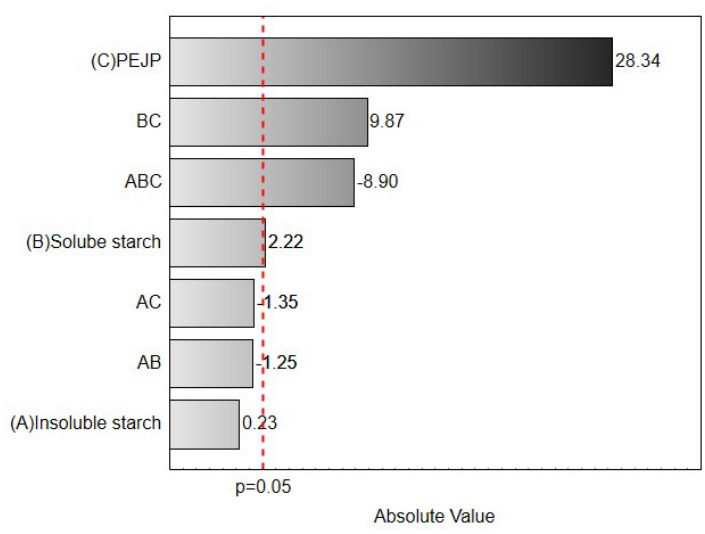
Figure 1. Pareto Chart showing the effect (absolute value) of the variables (SS, IS, and PEJP) on the antioxidant potential of the starch-PEJP films. The dashed line denotes the significance level − horizontal bars crossing the dashed line significantly interfere with the response.